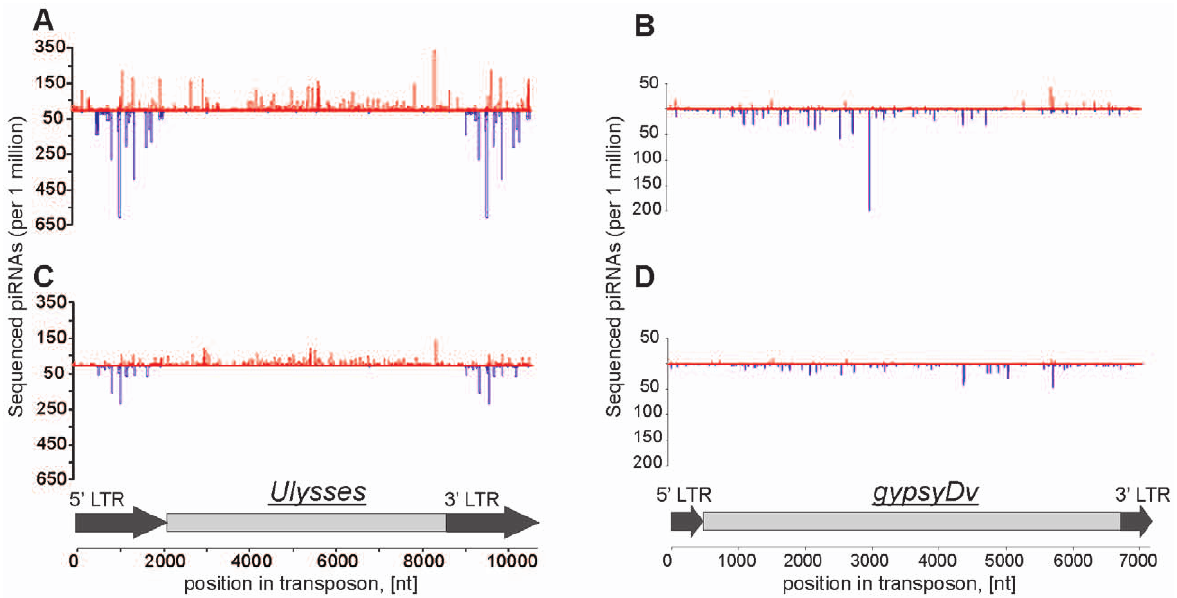
Figure 3. The pattern of piRNAs distribution along transposons in testes. Distribution of Ulysses -piRNAs in testes of strain 9 (A) and strain 160 (C). The distribution of piRNAs homologous to gypsyDv in testes of strain 9 (B) and strain 160 (D). Sense small RNAs are indicated in red, antisense – in blue.